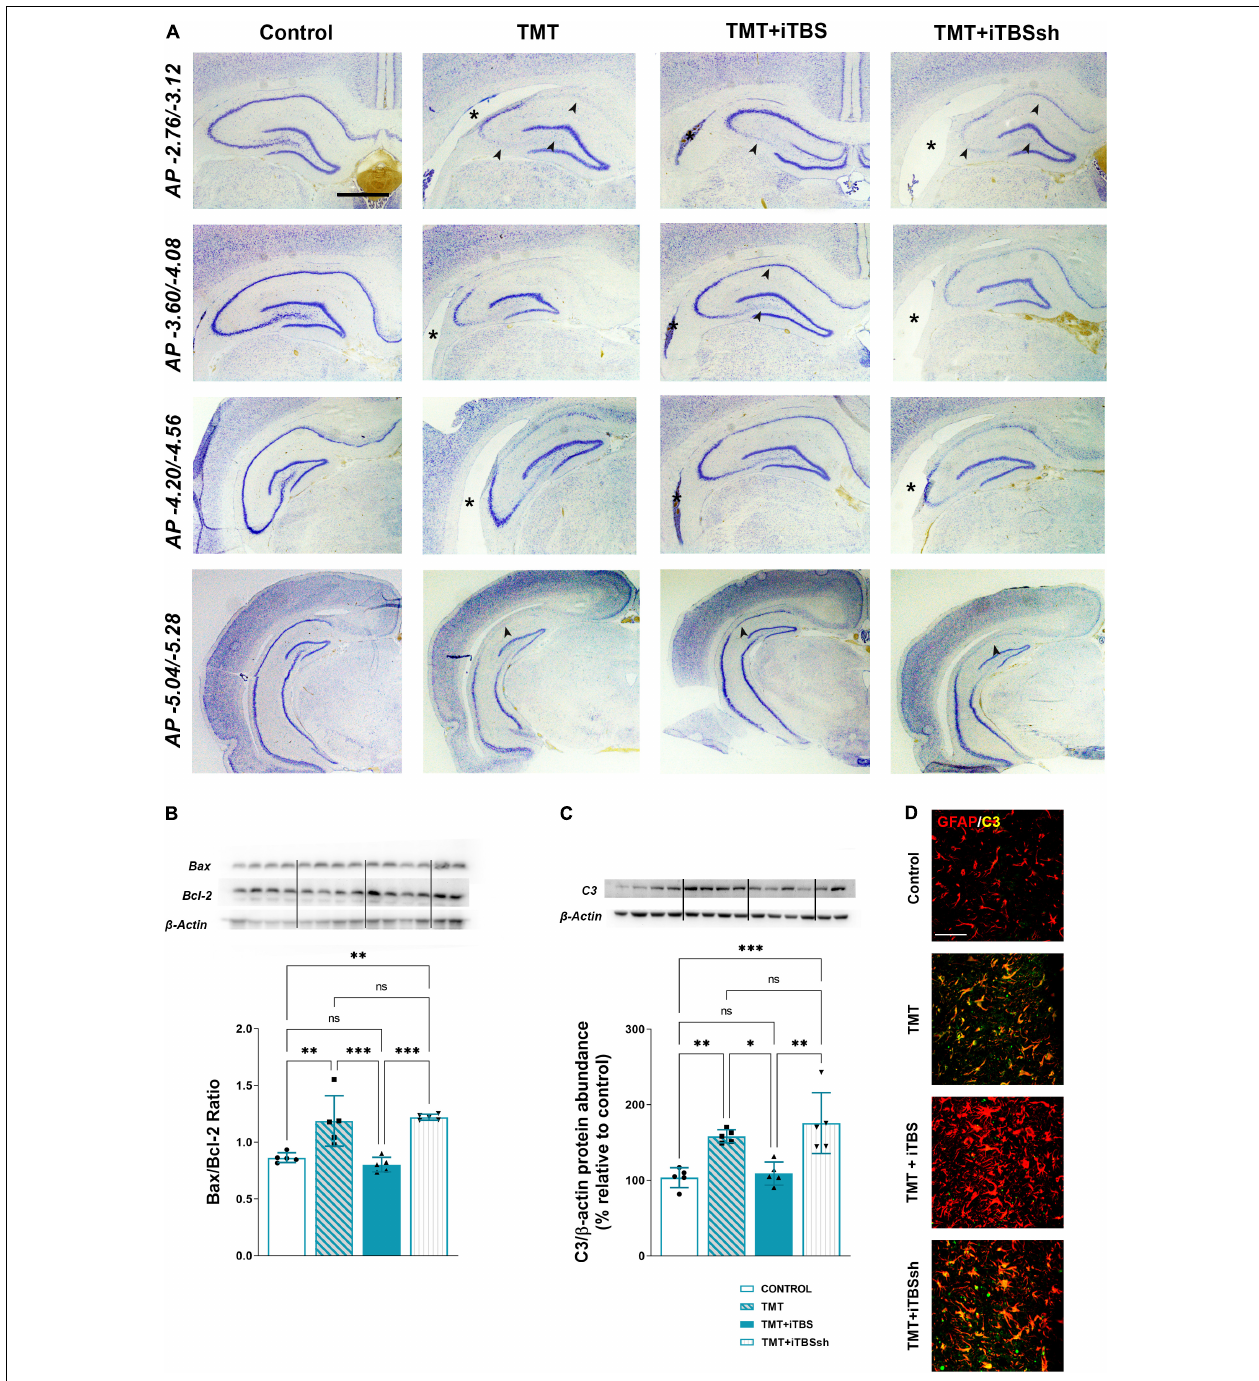
FIGURE 3 | Effect of iTBS treatment on TMT-induced neuronal death and inflammation. (A) Thionine-stained coronal sections at different stereotaxic anterior-posterior ( AP ) coordinates. Arrowhead indicates thinned neuronal cell layers, while asterisk marks the position of the lateral ventricle for a comparison. Scale bar = 500 µ m, applies to all micrographs. Representative membrane and semi-quantitative Western blot analysis showing (B) relative Bax/Bcl-2 and (C) C3 protein abundance, expressed relative to control, arbitrary defined as 100%. Bars in (B) represent the ratio between Bax and Bcl-2 relative abundance, determined as mean OD ratio of the specific protein band to actin band for each group ± SEM (from n = 5 individual animals, in 2–4 technical replicates). Bars in (C) represent the mean OD of the C3 band and actin band in each group normalized to control (arbitrarily defined as 100%) ± SEM (from n = 5 individual animals, in 2–4 technical replicates). Results of post hoc Tukey’s test and significance shown inside graphs: ∗ p < 0.05, ∗∗ p < 0.01, ∗∗∗ p < 0.001, ∗∗∗∗ p < 0.0001, ns, no significance. Dots in the graphs represent values of individual animals. (D) Double immunofluorescent staining of coronal hippocampal sections captured in the same region levels directed to GFAP ( red ) and C3 ( green ). Scale bar = 50 µ